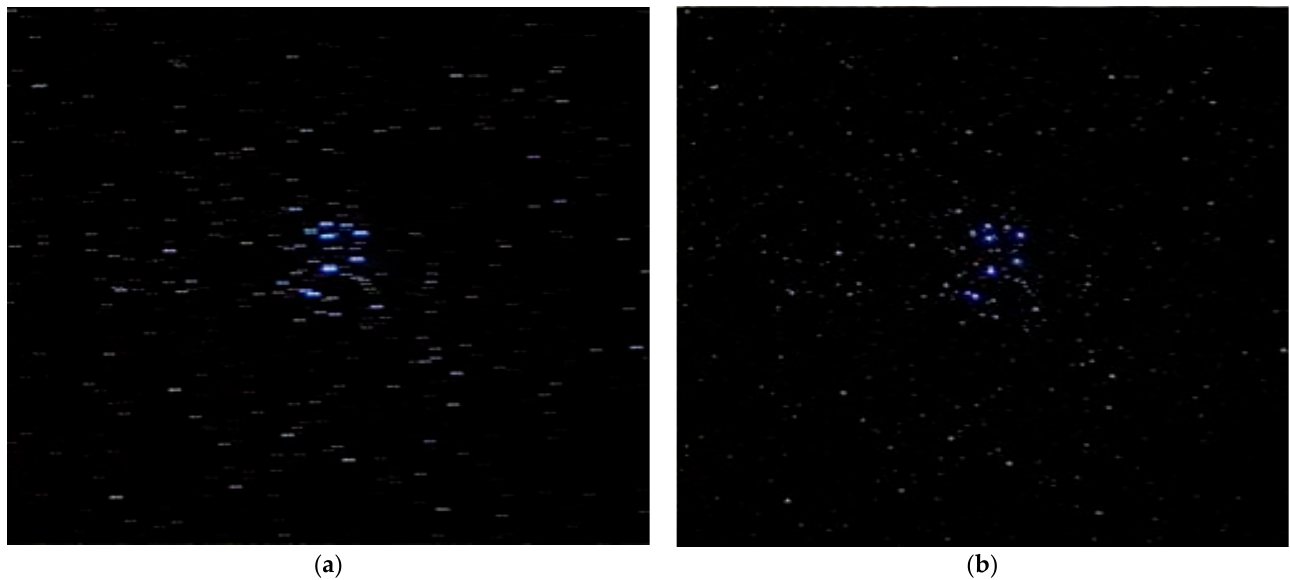
Figure 22. Technology samples (a6100) ( a ) without sensor and ( b ) with on-sensor. Samples taken with the process discussed are attached in Figure 23a–e. These photos were captured in the middle of the populated city of Ranchi, Jharkhand, with a light pollution of Bortle 5.5. The experiment was carried out during a rare, dark, starry night sky with no clouds in such high light pollution. These are a stack of 600 light frames, each of 5-s exposure, 30 dark frames, 30 bias frames, and 50 flat frames. The images of the Orion Nebula and Scorpius constellation were taken in the open air, in the light pollution of Bortle class 5, brightness = 1.27 mcd/m 2 , artif. brightness = 1100 ucd/m 2 , in an uncontrolled environment (in terms of wind speed and temperature). The artificial sky brightness levels are those used in the legend and indicate the following: up to 1% above the natural light (black); from 1 to 8% above the natural light (blue); from 8 to 50% above natural nighttime brightness (green); from 50% above natural to the level of light under which the Milky Way is no longer visible (yellow); from Milky Way loss to estimated cone stimulation (red); and very high nighttime light intensities, with no dark adaption for human eyes (white).